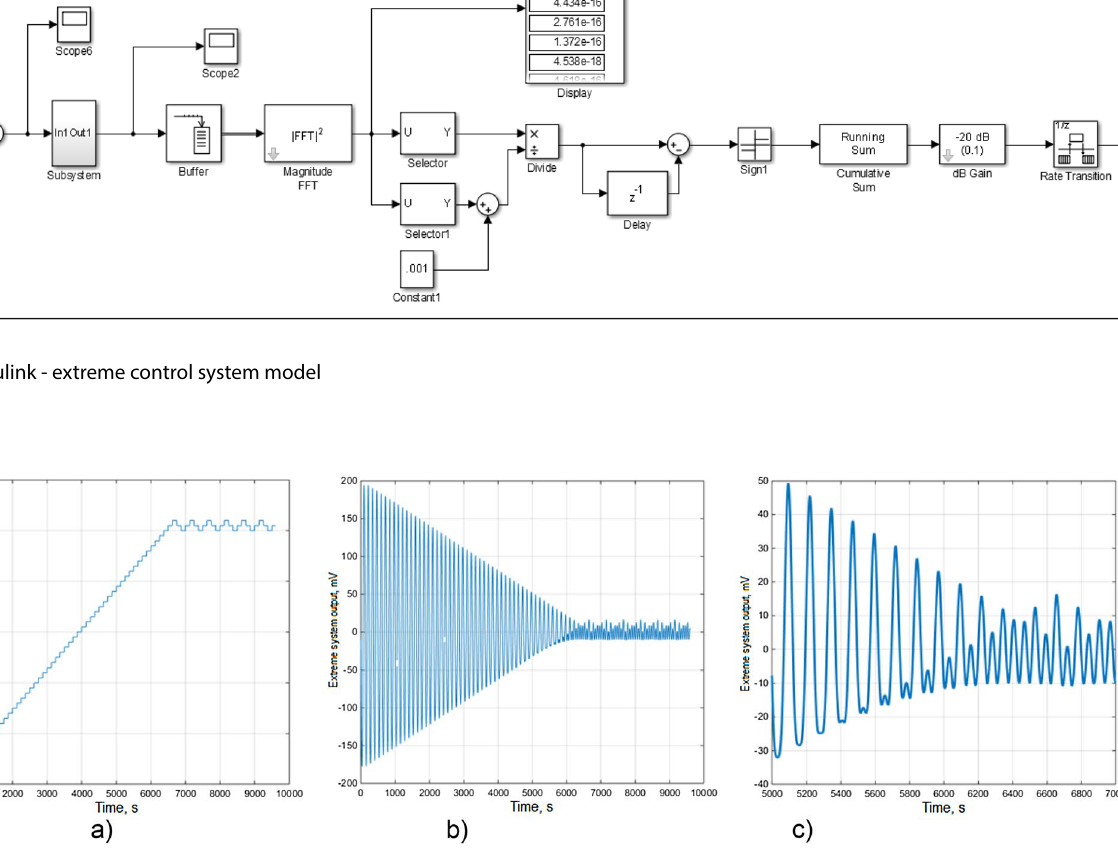
Fig. 8 Oscillograms of extremum search: a pressure change; b changing the output signal; c fragment of changing the output signal when the extremum is